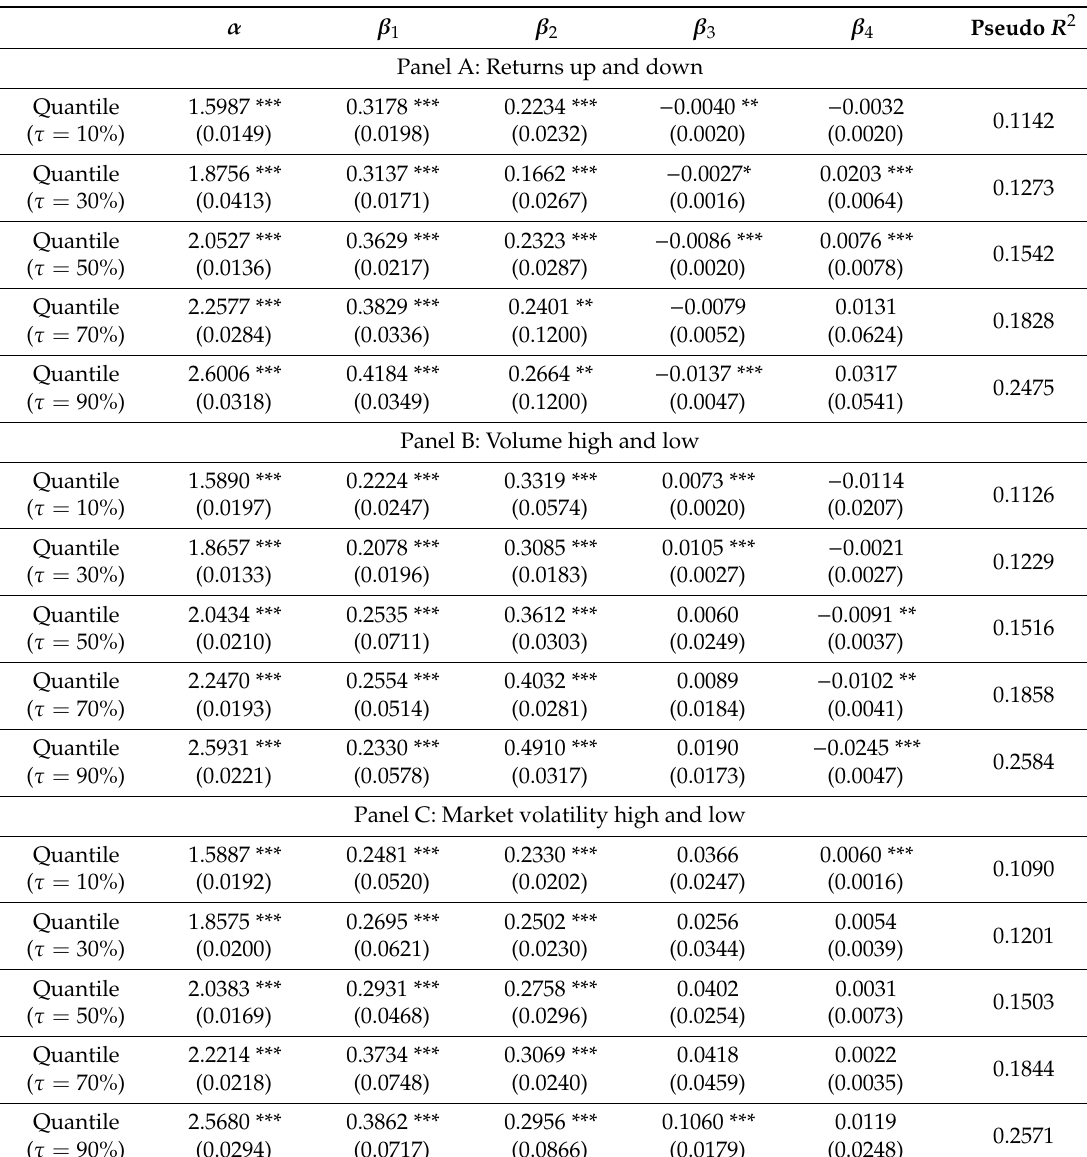
Table 7. Quantile regressions on estimates of herding behavior in market conditions in